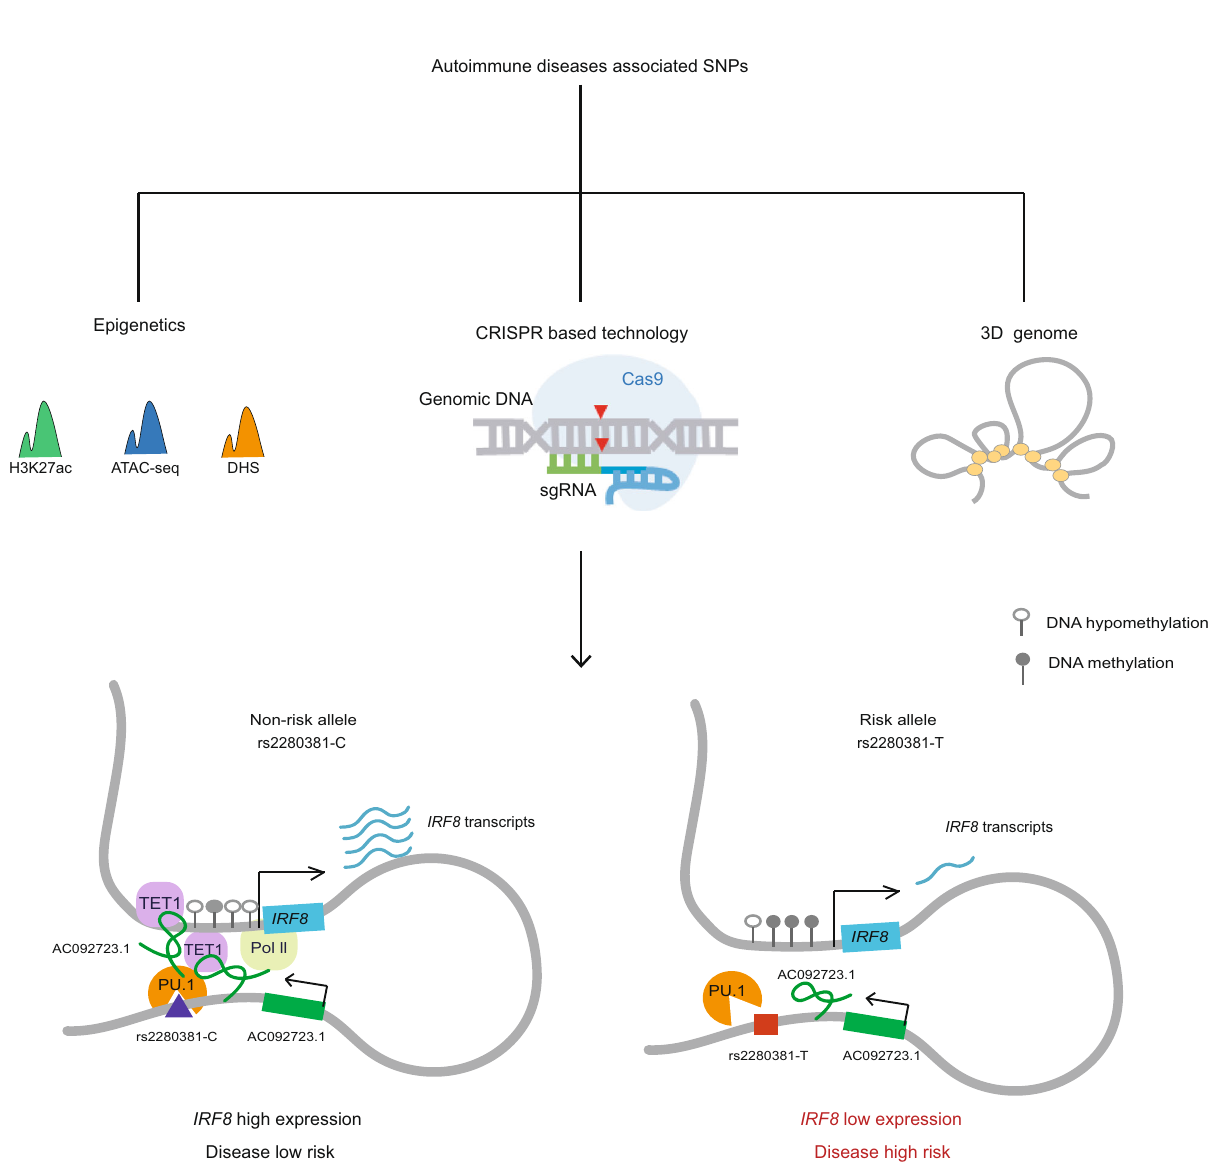
Fig. 6 Model for rs2280381 regulates IRF8 expression mediating disease risk. The rs2280381-containing region forms a gene-loop with the IRF8 promoter region. The rs2280381 T risk allele has lower PU.1-binding af fi nity than the non-risk C allele, which results in the reduced expression of AC092723.1, upregulation of methylation levels at IRF8 promoter, and the decreased expression of IRF8 contributing to SLE risk. DHS DNase I hypersensitive